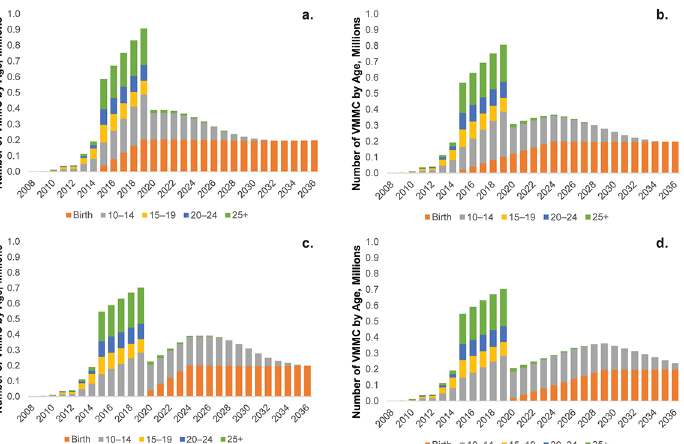
Fig 3. Annual number of VMMCs to be conducted under four timing scenarios. (a) EIMC introduced immediately and scaled up to 80% over 5 years (EIMC 5), (b) EIMC introduced immediately and scaled up to 80% over 10 years (EIMC 10), (c) EIMC introduced after 5 years and scaled up to 80% over 5 years (EIMC d5), (d) EIMC introduced after 5 years and scaled up to 80% over 10 years (EIMC d10).